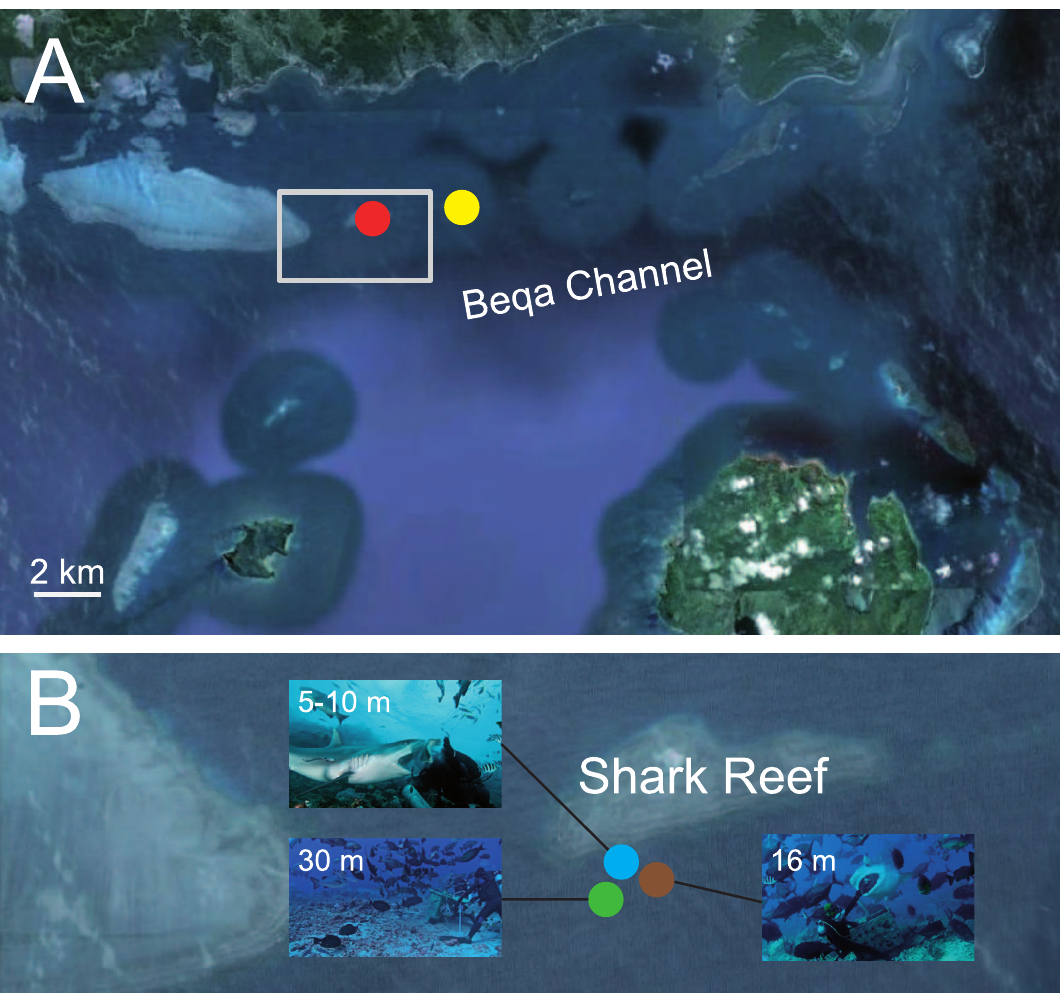
Figure 1. Study site on the southern coast of Viti Levu, Fiji. (A) Shark Reef (red dot) and Lake Reef (yellow dot); (B) feeding site at 30 m (green dot) where sharks and other fish are attracted at the beginning of the first dive of the day, a C. amblyrhynchos taking a fish fillet from the hand of the feeder at the shallow (5–10 m) feeding site (blue dot), and a G. cuvier taking a tuna fish head from the hand of the feeder at the 16 m feeding site (brown dot) on the second dive of the day.